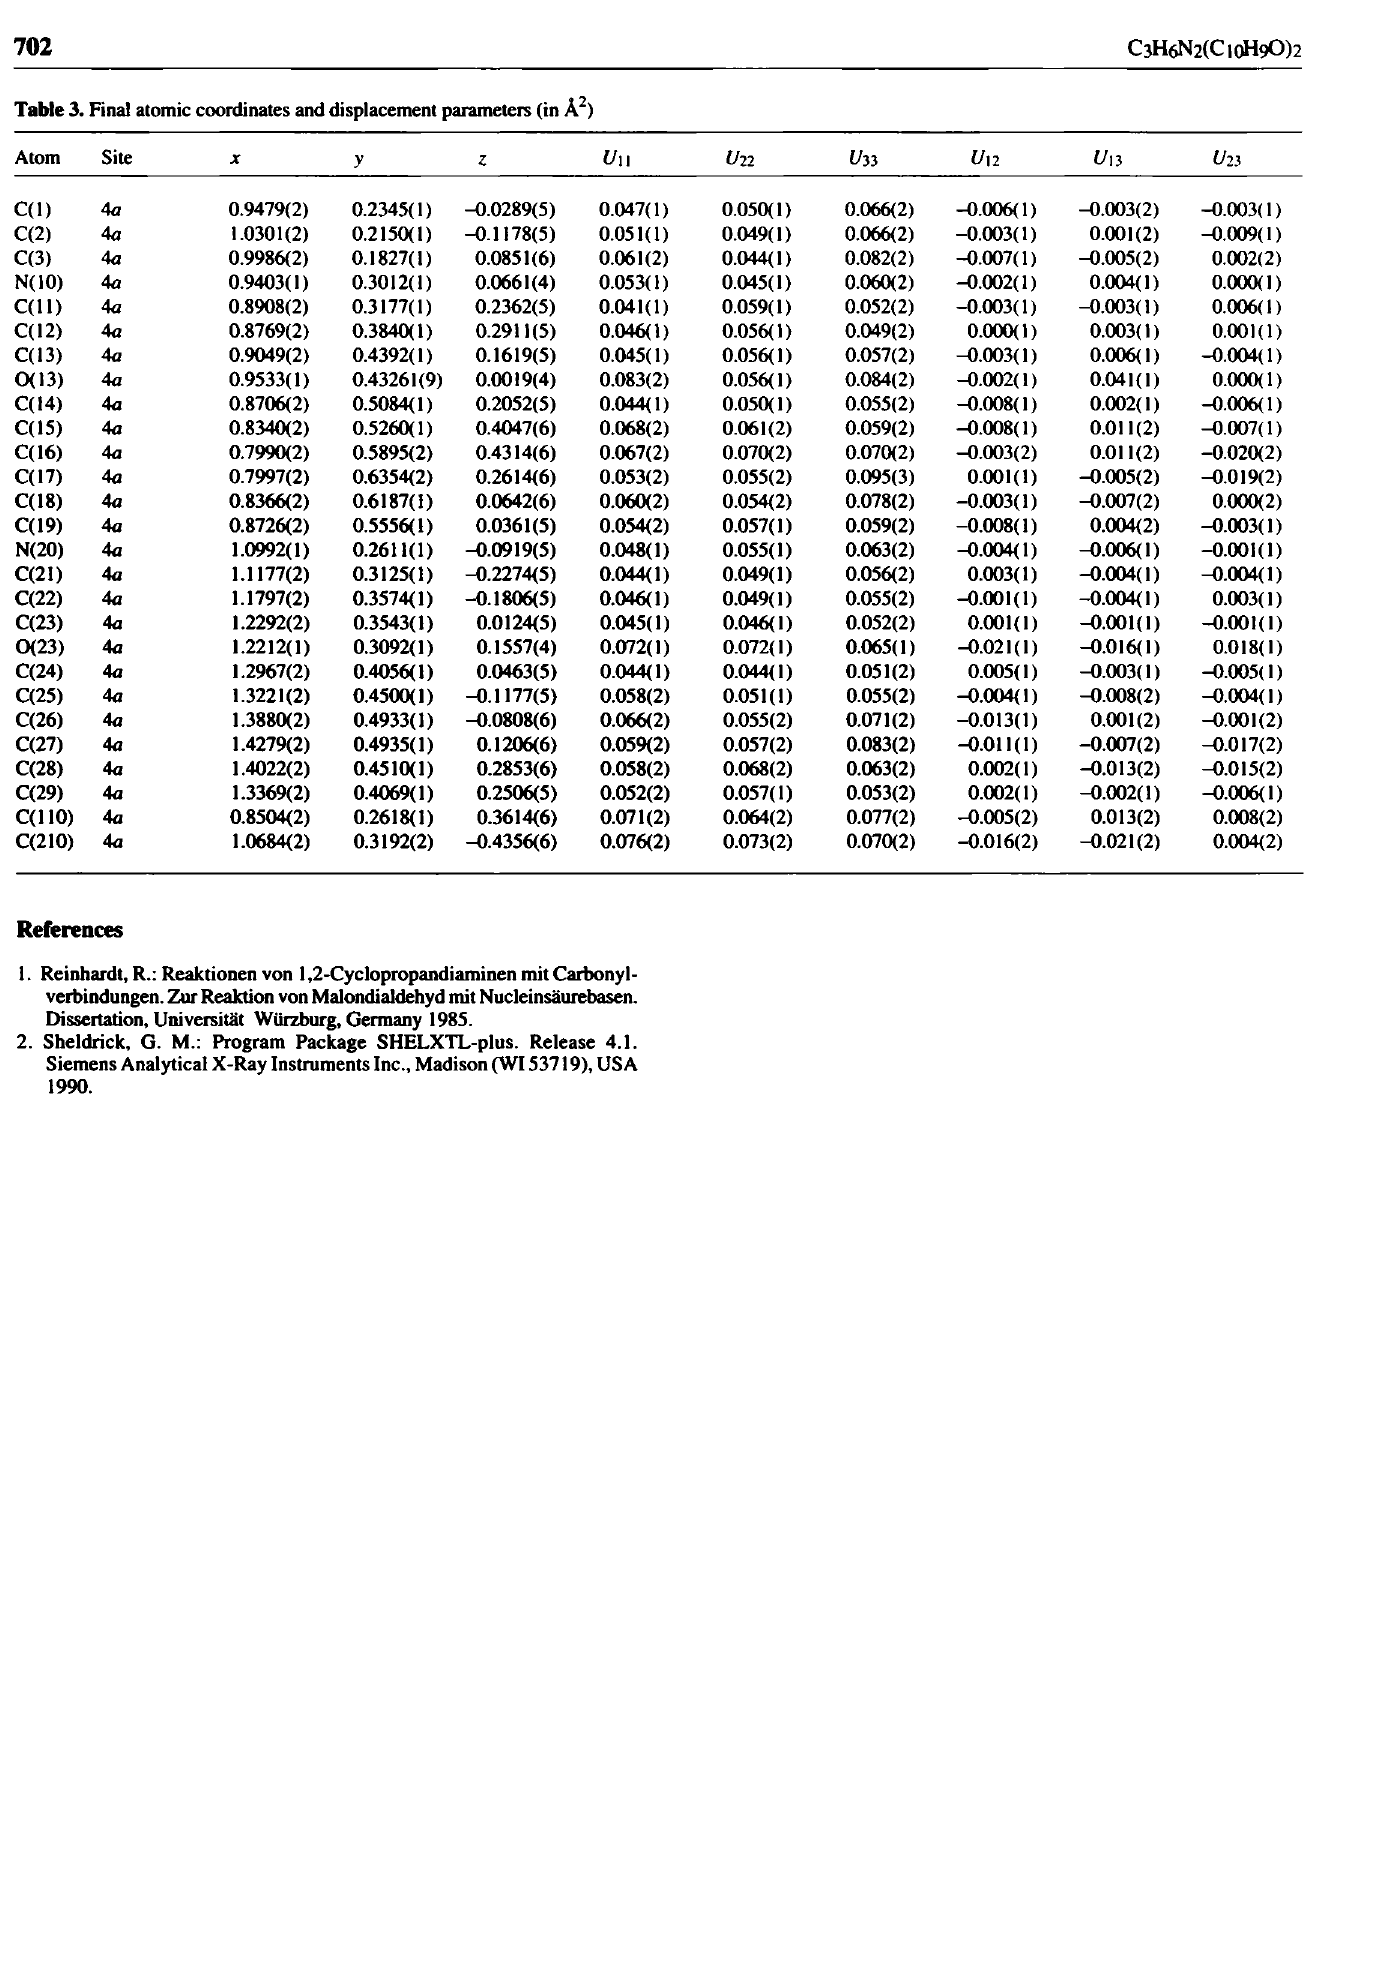
Table 3. Final atomic coordinates and displacement parameters (in